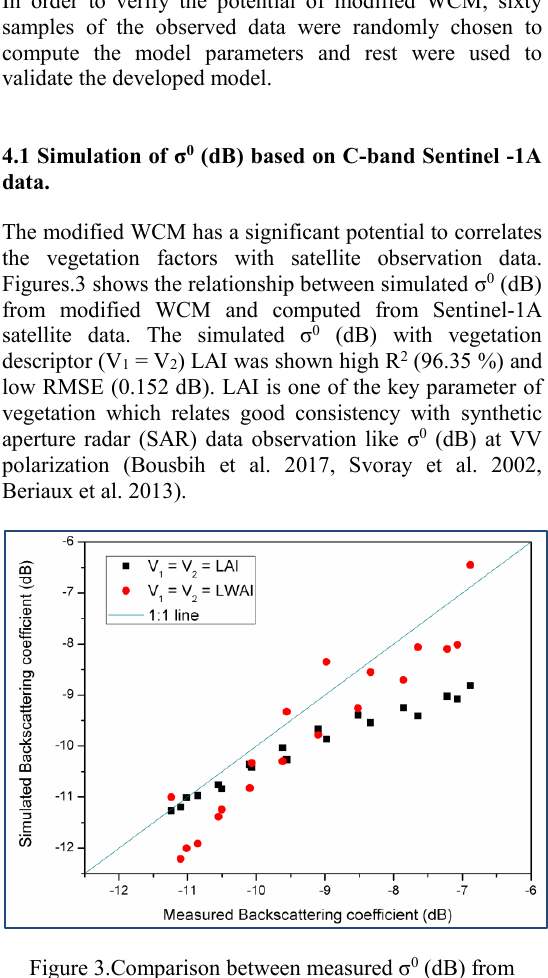
Figure 3.Comparison between measured σ 0 (dB) from Sentinel - 1A image and simulated σ 0 (dB) through modified WCM at VV polarization